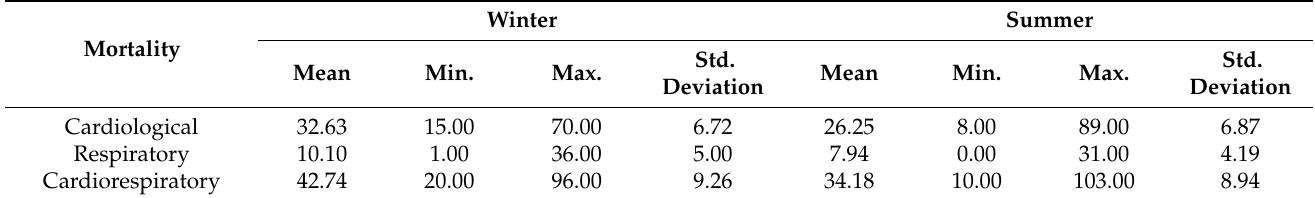
Table 1. Descriptive statistics for mortality (winter and summer).